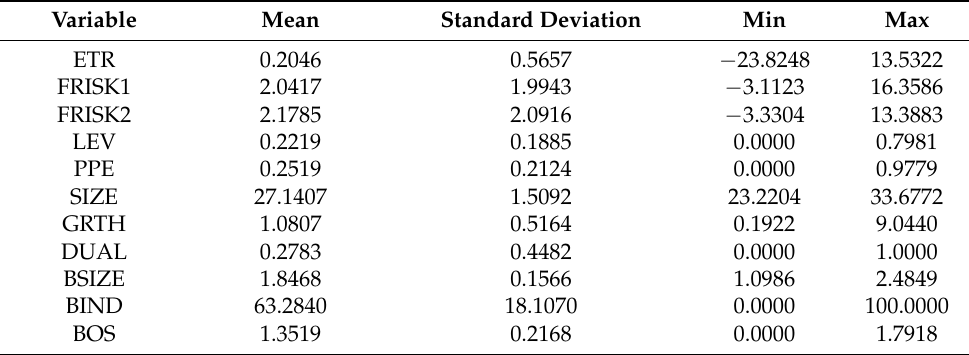
Table 3. Descriptive statistics of the research